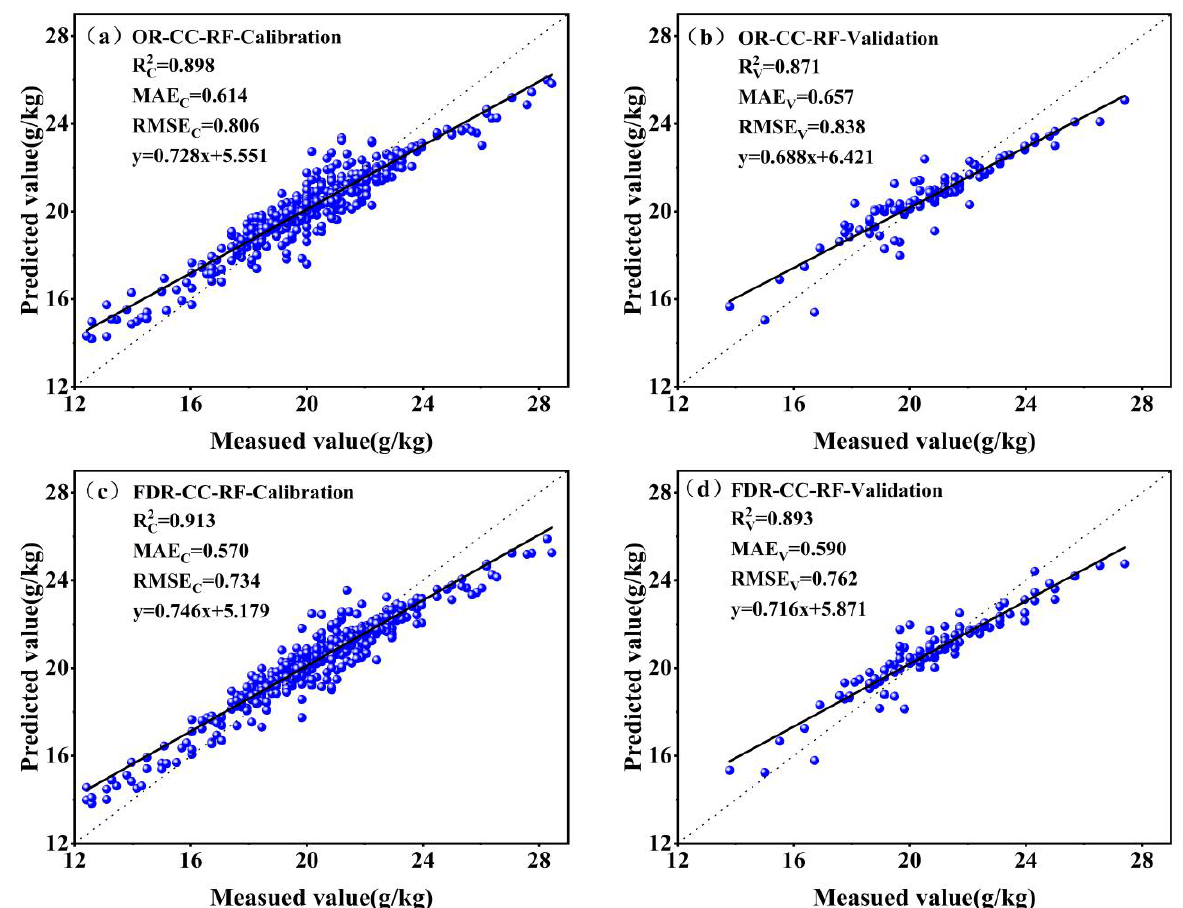
Figure 7. Scatter plot of predicted and measured SOM values for the CC signature band RF model (( a ) OR-CC-RF-Calibration; ( b ) OR-CC-RF-Validation; ( c ) FDR-CC-RF-Calibration; ( d ) FDR-CC-RF-Validation).